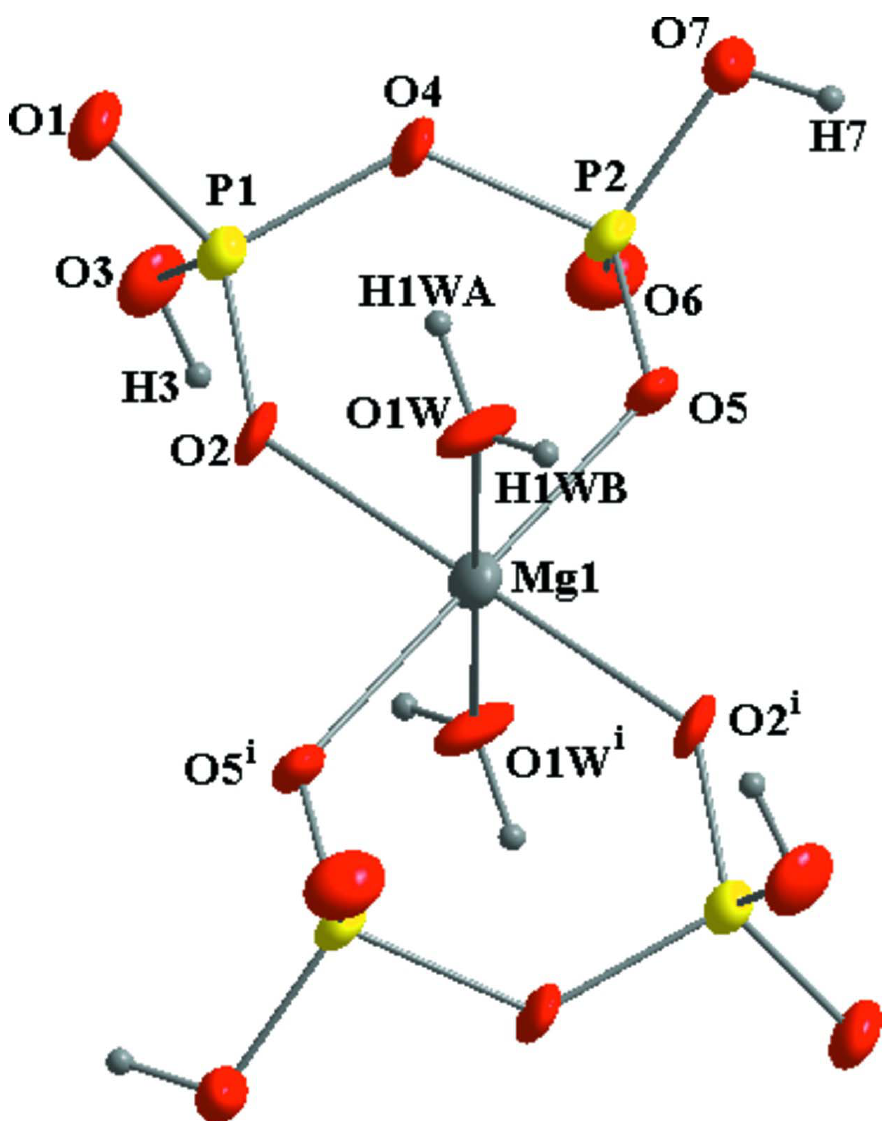
Mn(H P O ) .2H O. Displacement ellipsoids are drawn at the 50% probability level. [Symmetry 2 2 2 7 2 2